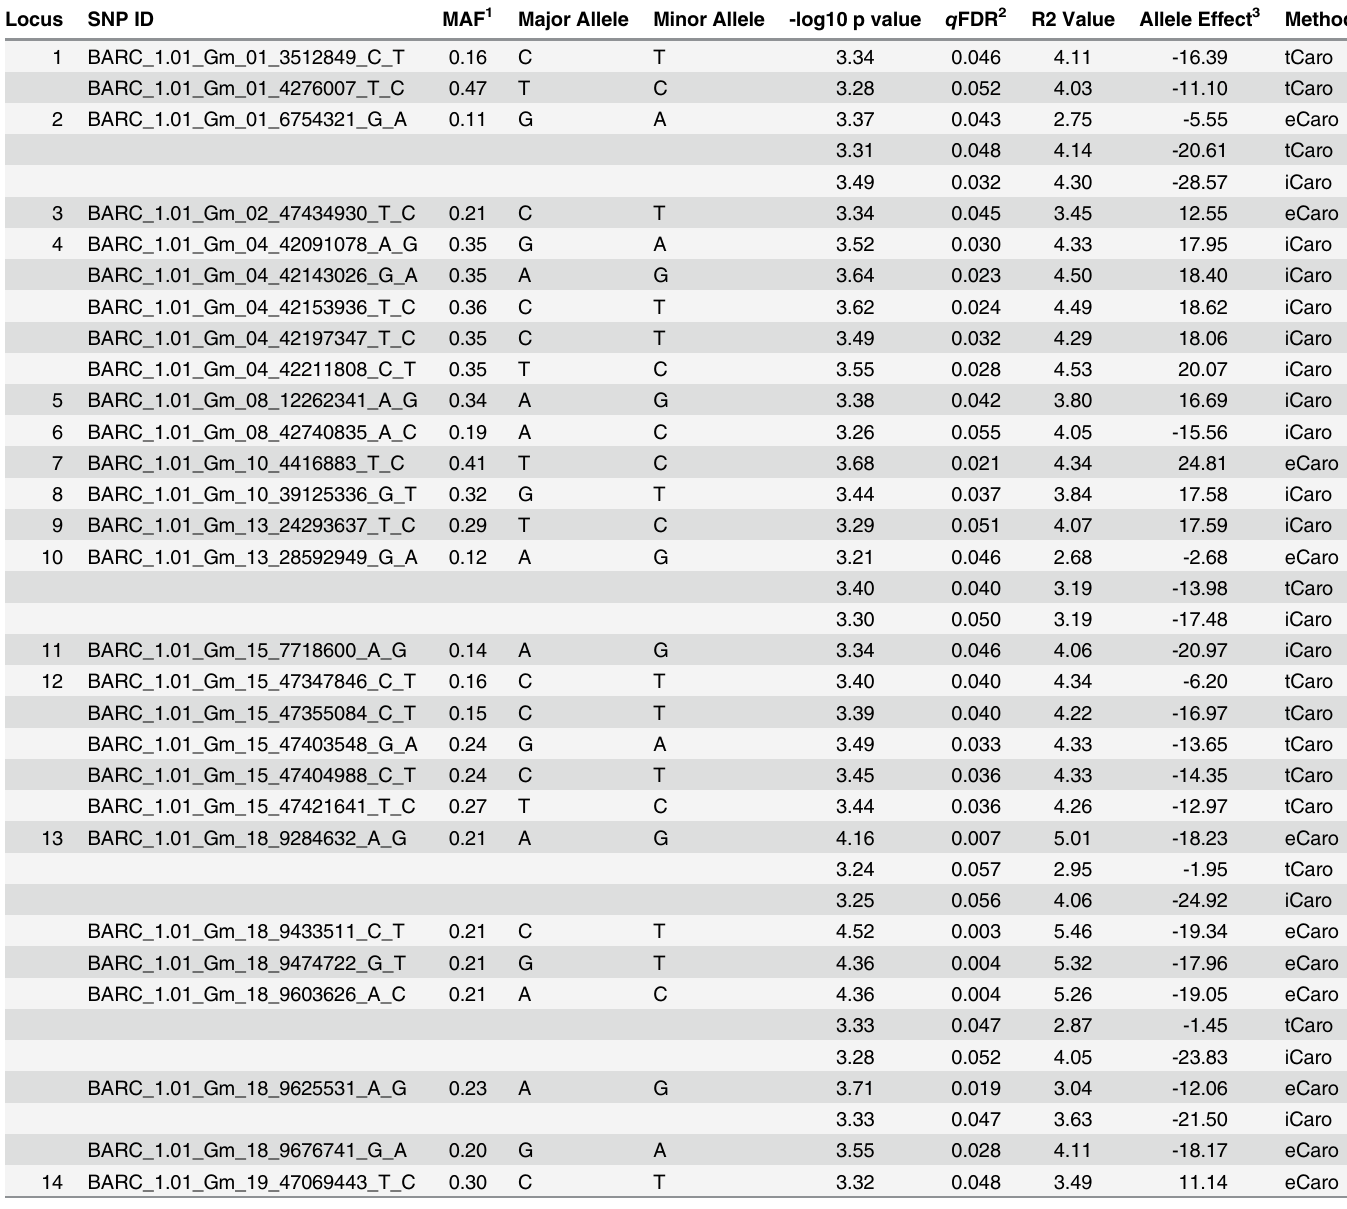
Table 1. List of 28 putative candidate SNPs significantly associated with extractable carotenoid content (eCaro), wavelet transformed spectral reflectance carotenoid content (tCaro) and spectral index carotenoid content (iCaro) using MLM+Q+K model. The 28 SNPs identified 14 putative genomic loci. Locus SNP